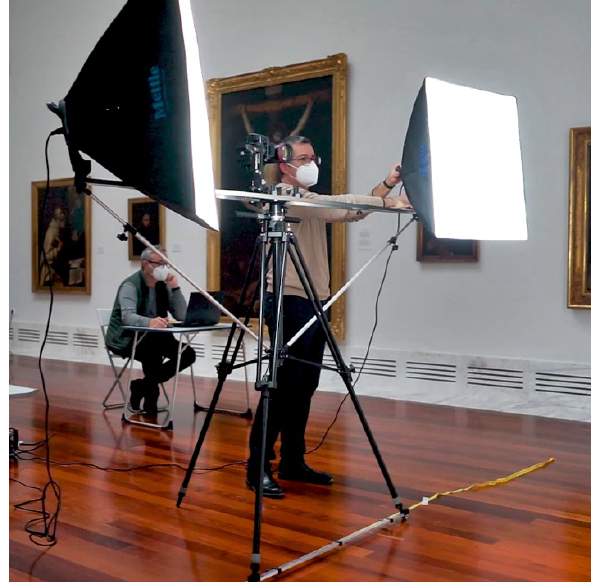
Figure 3 . Lighting system and special mount.